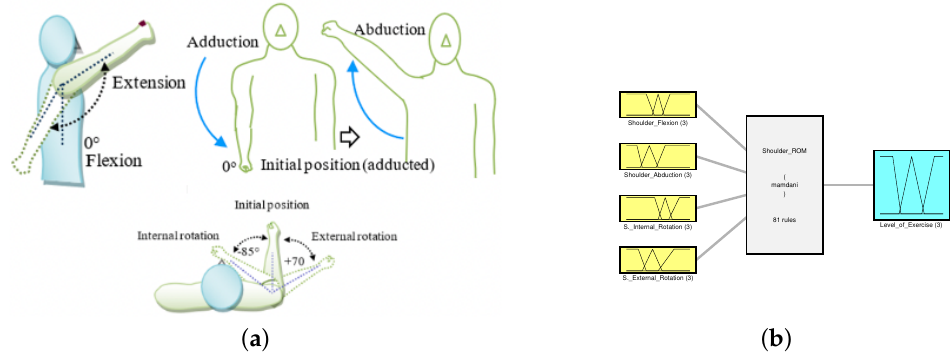
Figure 5. Shoulder ROM FIS and its respective motions: ( a ) Schematic of shoulder joint motions; ( b ) the FIS for determining the level of